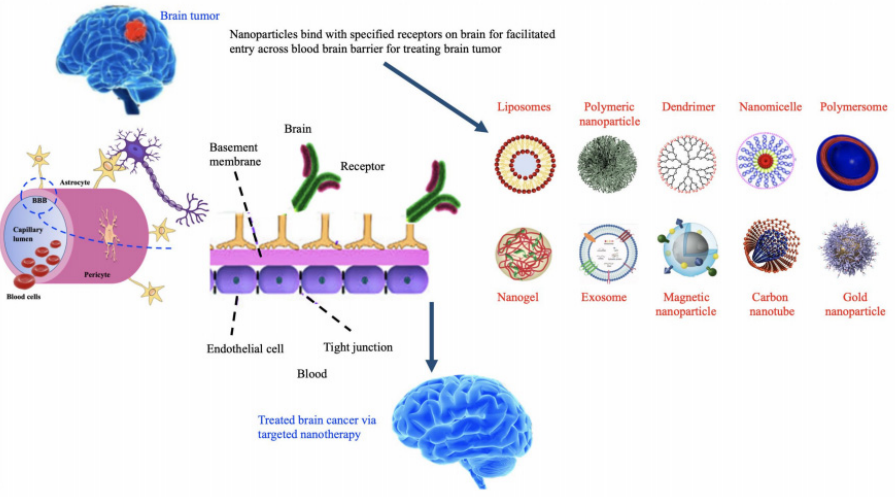
Figure 8. Nanomaterials for the treatment and diagnosis of brain tumors. Adopted from Simona et al., 2020 [183]. Table 2. Different types of nanomaterials with their mechanism of action.